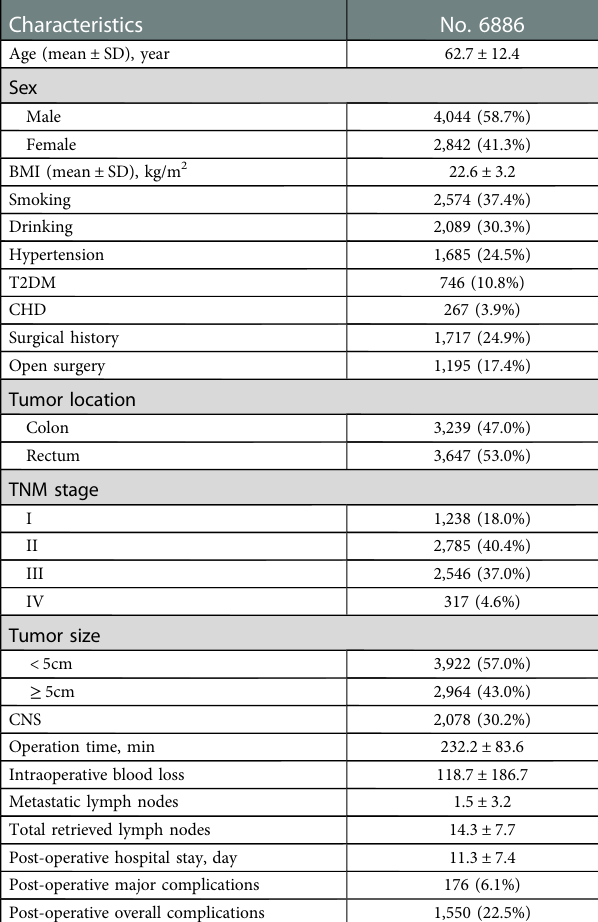
TABLE 1 Clinical characteristics of CRC